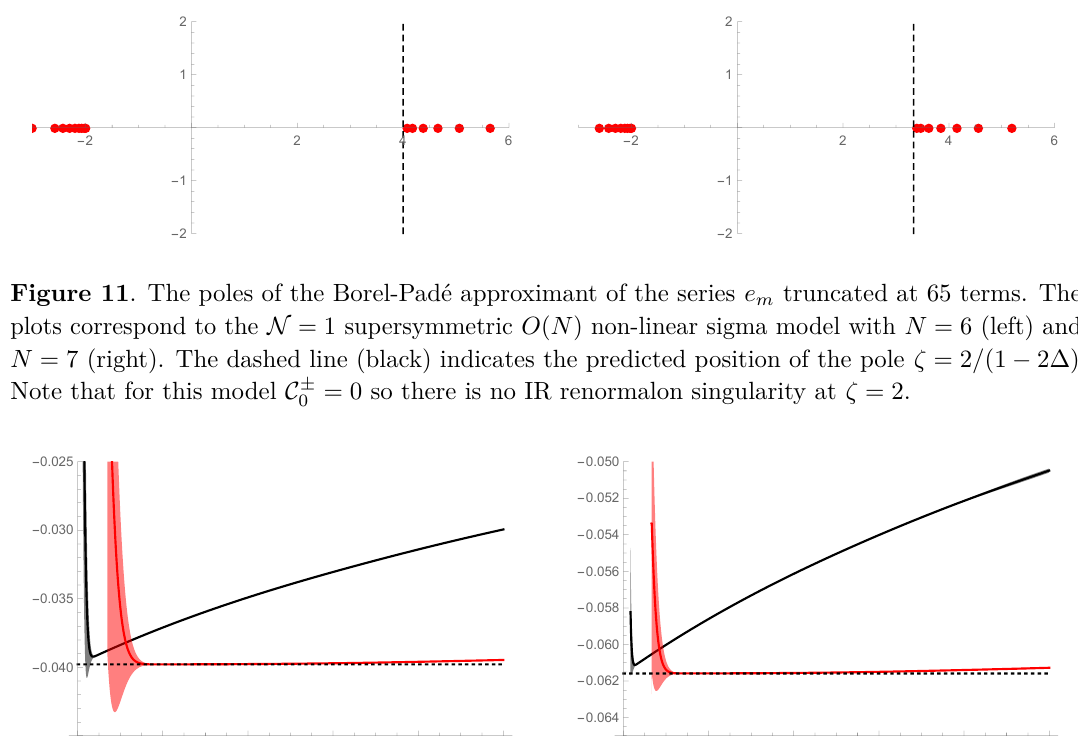
0.0 Figure 12 . Plot of the function f ( α ) in (4.57) for the N = 1 supersymmetric O ( N ) non-linear sigma model with N = 6 (left, black) and N = 7 (right, black) as well as their respective second Richardson transforms (red). The dashed line is the predicted asymptotic value. Note that for this model C ± = 0 so this is the leading exponentially small correction. The shaded areas correspond to 0 error estimates from the convergence of the Padé